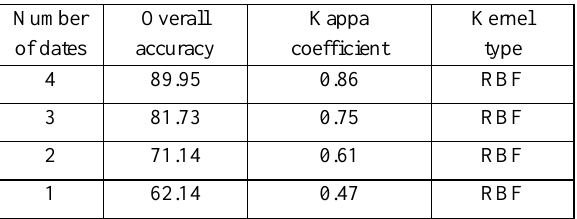
Table 3. Accuracy parameters of multi-temporal